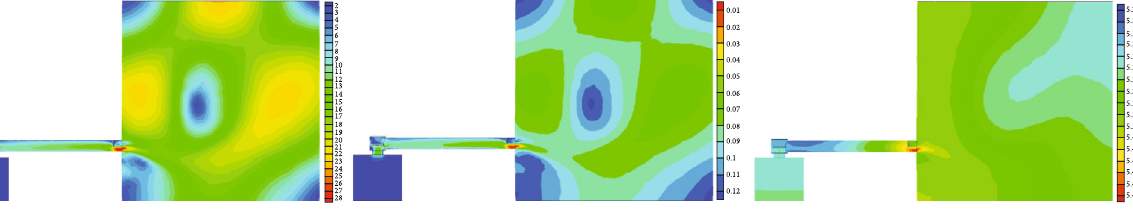
Figure 7: The distribution of fl ow fi eld in rapid decompression process (the left is the velocity distribution, the middle is the Mach number distribution, and the right is the total pressure